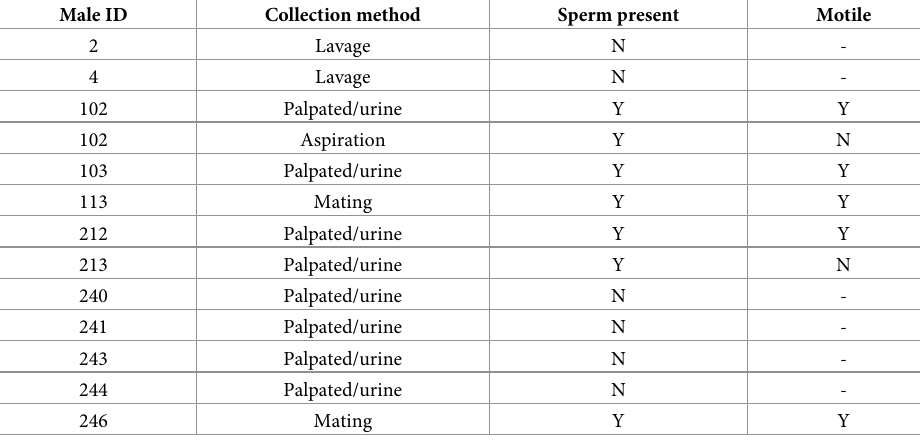
Table 1. Tuatara ( Sphenodon punctatus ) sperm sample